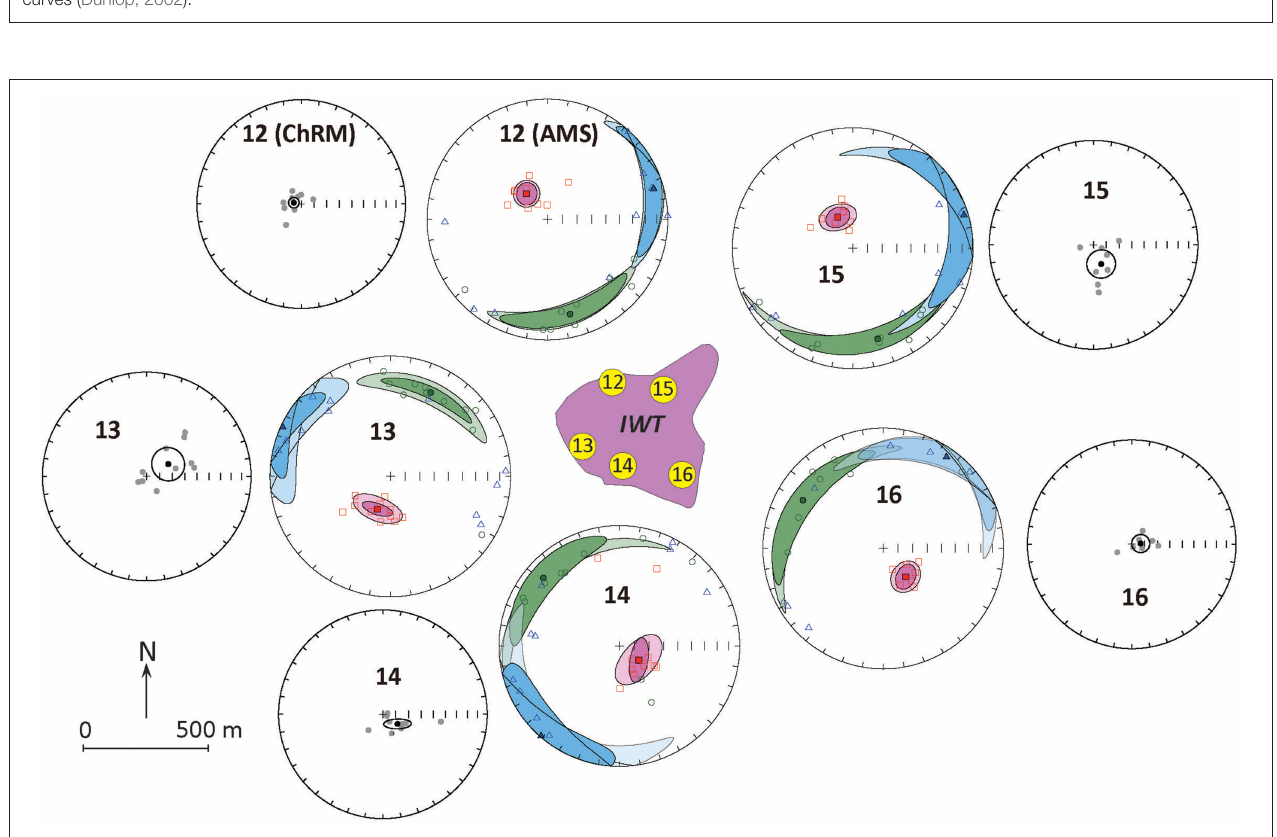
FIGURE 6 | Stereographic projections of anisotropy of magnetic susceptibility AMS and characteristic remanent magnetization (ChRM) data for 5 sites in the intrusive welded tuff (IWT). For each stereographic projection, eigenvectors are displayed on an equal area plot using the lower hemisphere projection with the convention that maximum ( k 1 ), intermediate ( k 2 ), and minimum ( k 3 ) susceptibility are represented as red squares, blue triangles, and green circles. Confidence ellipses were calculated on the basis of the Jelinek method (inner ellipses with darker colors) and the site parametric bootstrap statistics (outer ellipses with brighter